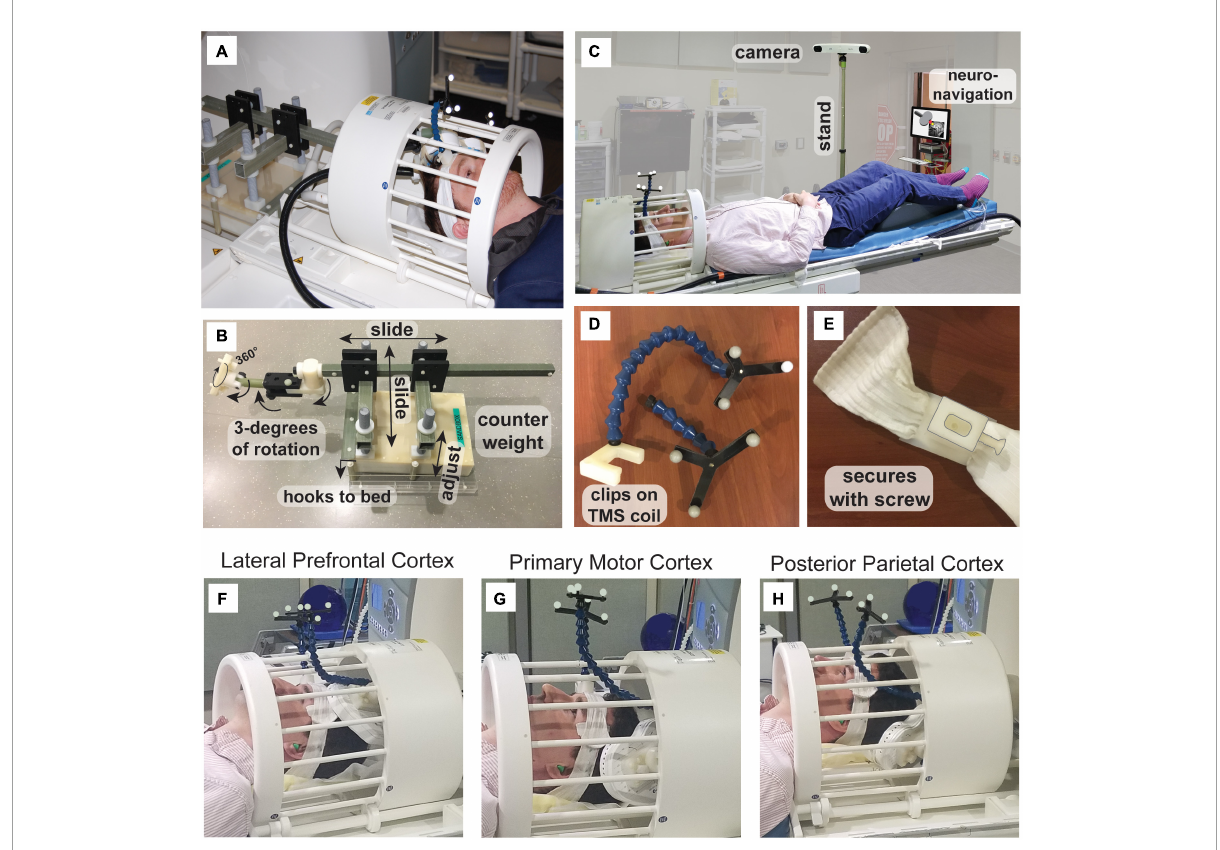
FIGURE1 Concurrent TMS-fMRI setup. (A) The TMS coil enters the back of the birdcage receive coil and is supported by (B) a custom arm. The supporting arm can be adjusted with 3 degrees of freedom. The arm attaches to a counterweight with three translations of spatial movement along the cardinal axes of the bore. The assembly hooks to the patient bed move with the MR receive coil. (C) Neuronavigation can be conducted within the MRI room using a custom MR-compatible stand, such that the infrared tracking camera (not MR-compatible) can be positioned at the foot of the bed with the neuronavigation display visible from the doorway. For accurate targeting, during neuronavigation, we used (D,E) a custom head-tracker and coil-tracker that are detachable so that registration to anatomical image and TMS coil calibration can be conducted outside of the MRI. Example targeting of (F) lateral prefrontal cortex (PFC), (G) primary motor cortex (M1), and (H) posterior parietal